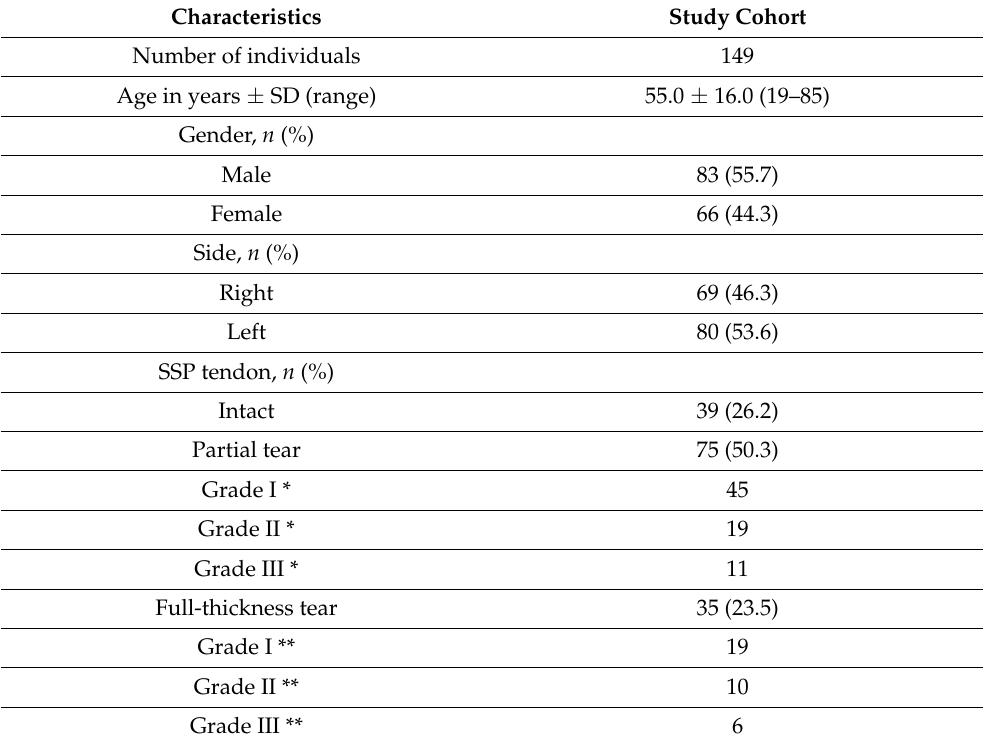
Table 2. Patients’